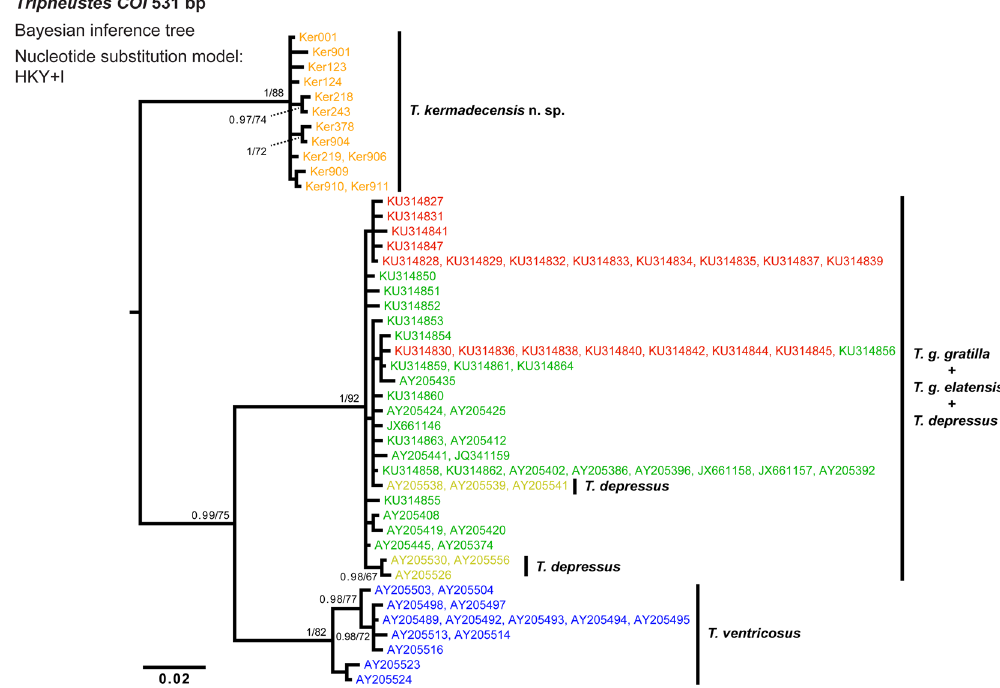
Figure 5. Phylogenetic tree reconstruction of Tripneustes COI sequences. The BI tree is based on 44 haplotypes, 531 bp long, representing all extant species of Tripneustes and is rooted with Lytechinus variegatus (not shown). Supporting values ( > 0.9 posterior probabilities and > 60% ML bootstrap values) are shown above the nodes. The colors of the specimen labels correspond to: Dark green – T . g . gratilla , Red – T . g . elatensis , Light green – T . depressus , Blue – T . ventricosus , and Orange – T . kermadecensis n. sp. Details on the sequences used for this tree are given in the Supplementary Tables S1 and